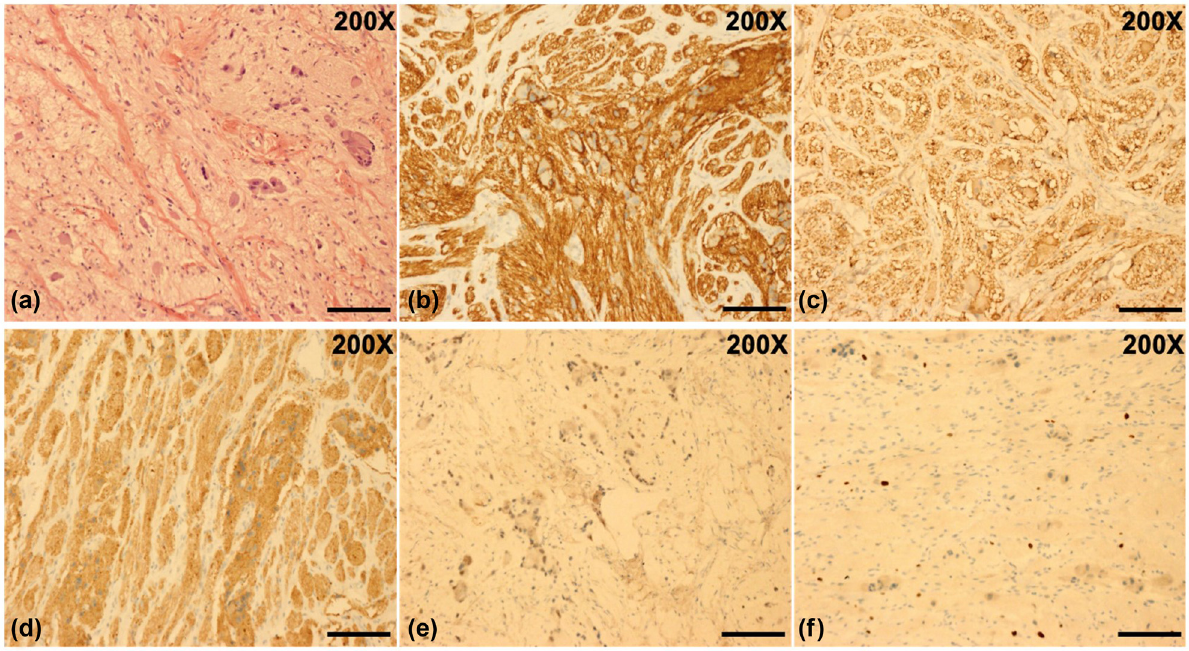
Figure 4: Histopathological examination of the tumor. ( a ) Hematoxylin - eosin ( H&E ) staining results of the tumor showed neuroblasts at di ff erent degrees of di ff erentiation arranged in nests and mature gangliocytes with fi brous connective tissue septa ( H&E, original mag - ni fi cation, 200 ×) ; ( b ) the number of CD56 - positive tumor cells was 175.7 ± 6.5 per 3 high power fi eld ( HPF ) ( CD56, original magni fi cation, 200 ×) ; ( c ) immunohistochemical staining results were positive for NSE and the number of these tumor cells was 163.3 ± 5.6 per 3 HPF ( NSE, original magni fi cation, 200 ×) ; ( d ) the number of Syn - positive tumor cells was 172.1 ± 25.2 per 3 HPF ( Syn, original magni fi cation, 200 ×) ; ( e ) the number of NeuN - positive cells was 122.7 ± 11.6 per 3 HPF ( NeuN, original magni fi cation, 200 ×) ; ( f ) the proportion of Ki - 67 - positive cells was 2 – 5% per HPF ( Ki - 67, original magni fi cation, 200 ×) . Scale bar = 200 μ m. ImageJ 1.50b with cell counter plugin ( https://imagej.nih. gov/ij/ ) was used for cell counting following the online